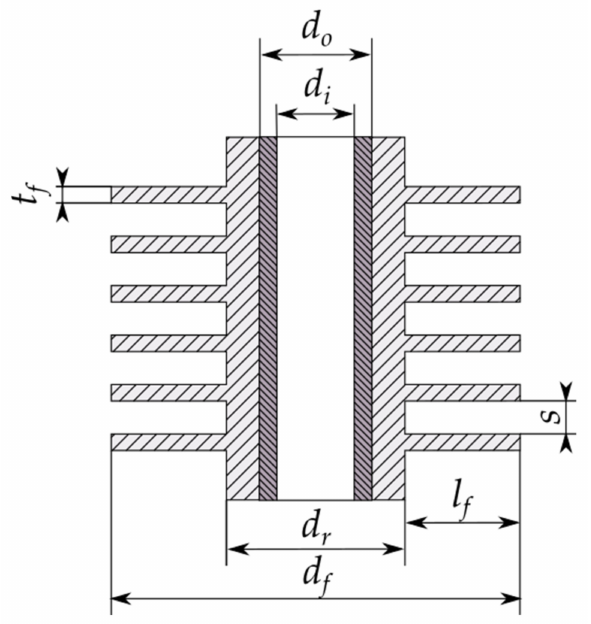
Figure 2. Geometrical dimensions of finned